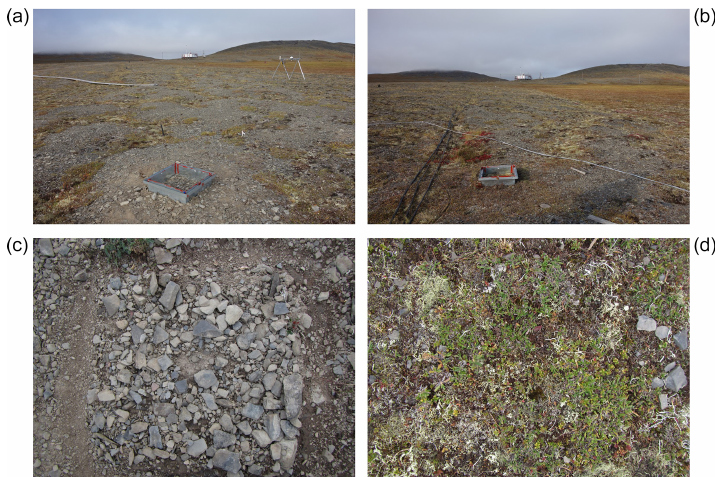
Figure A1. Examples of the barren (a, c) and lichen tundra (b, d) plots with close views (c, d) . Vegetation consists of lichens Flavocetraria sp., Thamnolia sp., Alectoria sp., dwarf-shrubs Dryas octopetala , Vaccinium vitis-idaea , Cassiope tetragona , and graminoids and forbs such as Carex spp. and Polygonum viviparum .